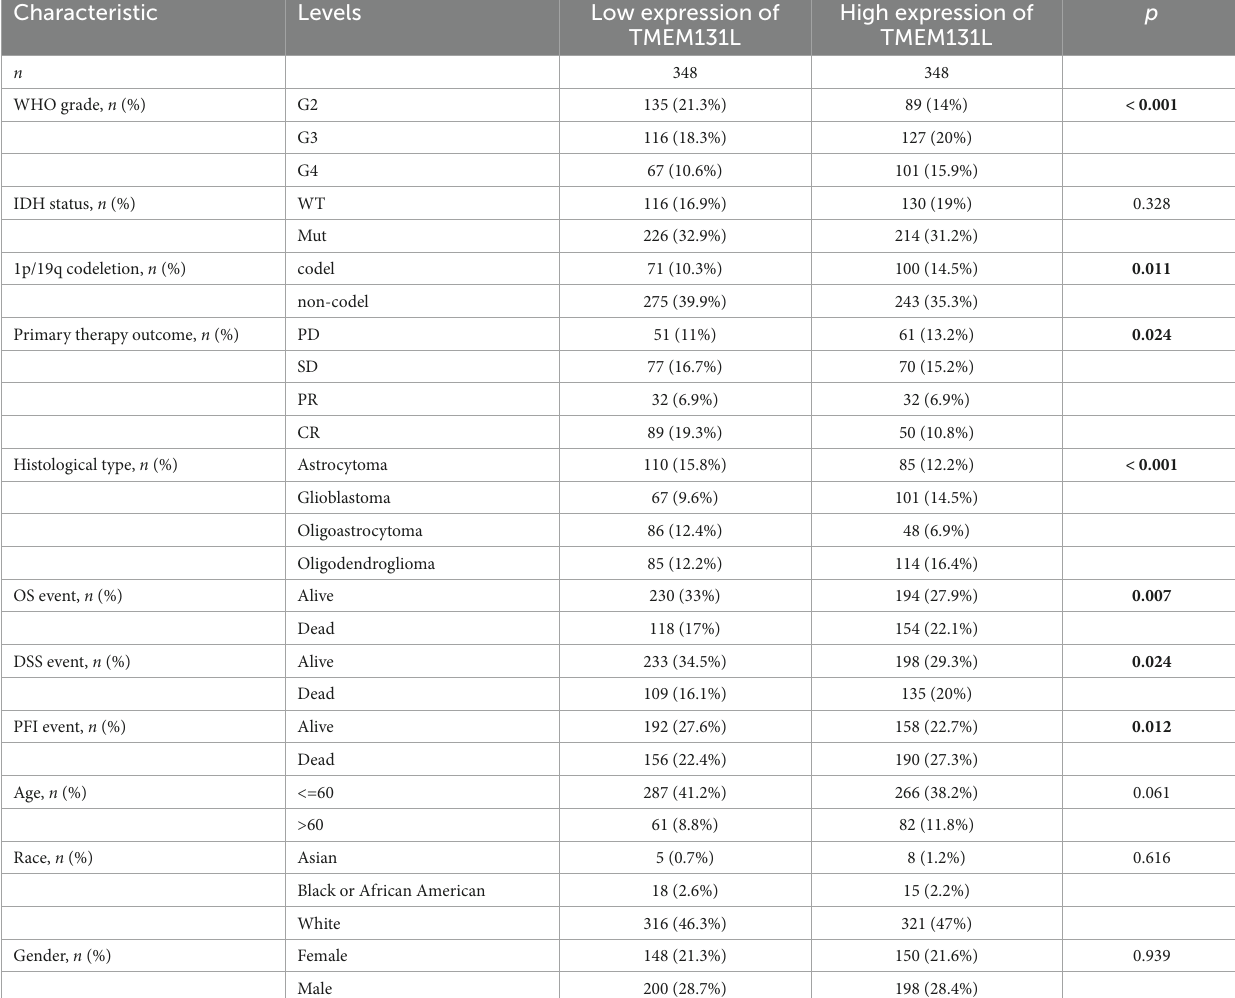
TABLE 1 Baseline analysis of clinicopathological data between TMEM131L high and low expression groups in the TCGA-GCBLGG dataset.